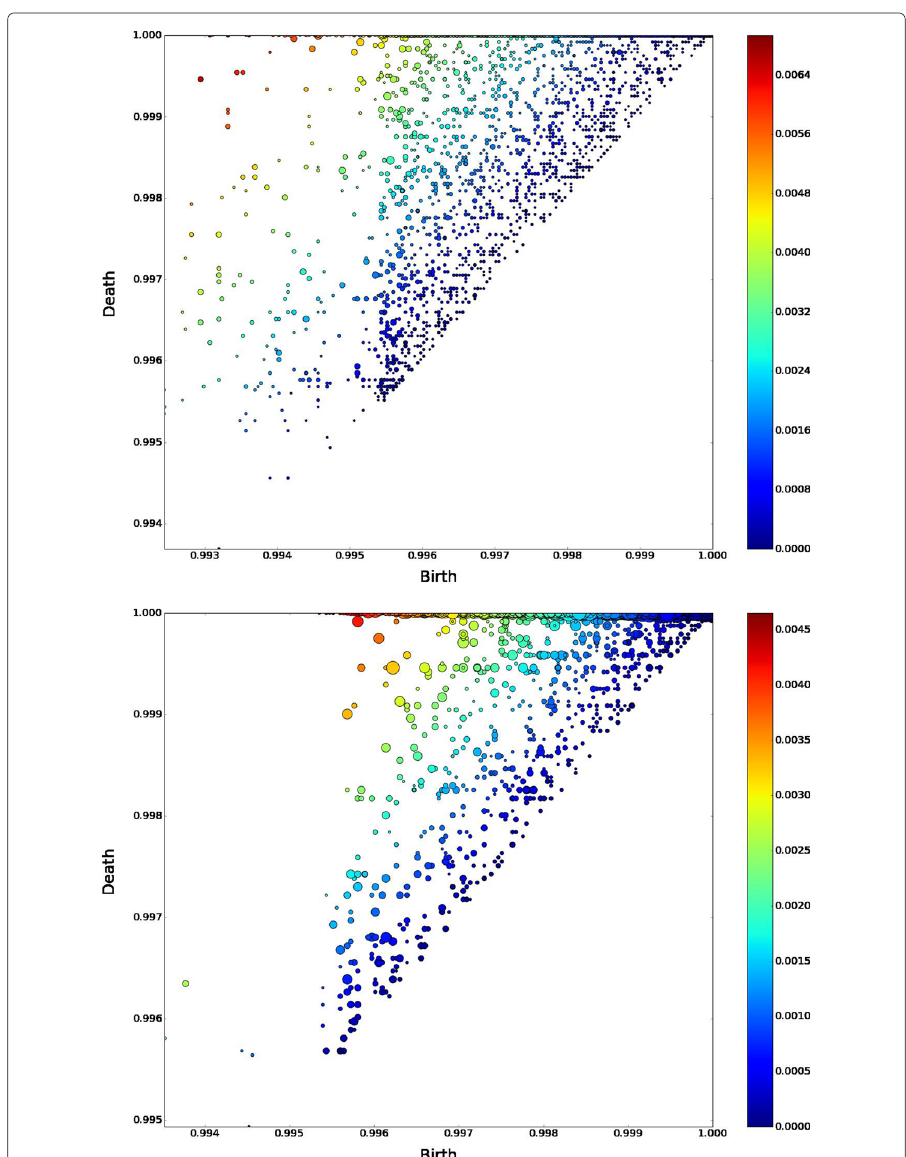
Fig. 8 Persistence diagrams for H 1 and H 2 . Persistence diagrams report the same information of barcodes, where each barcode is mapped to a peak function that is proportional to the life of the homological feature. The heatmap reports information on the length of the cycle and the coordinates are birth and death times